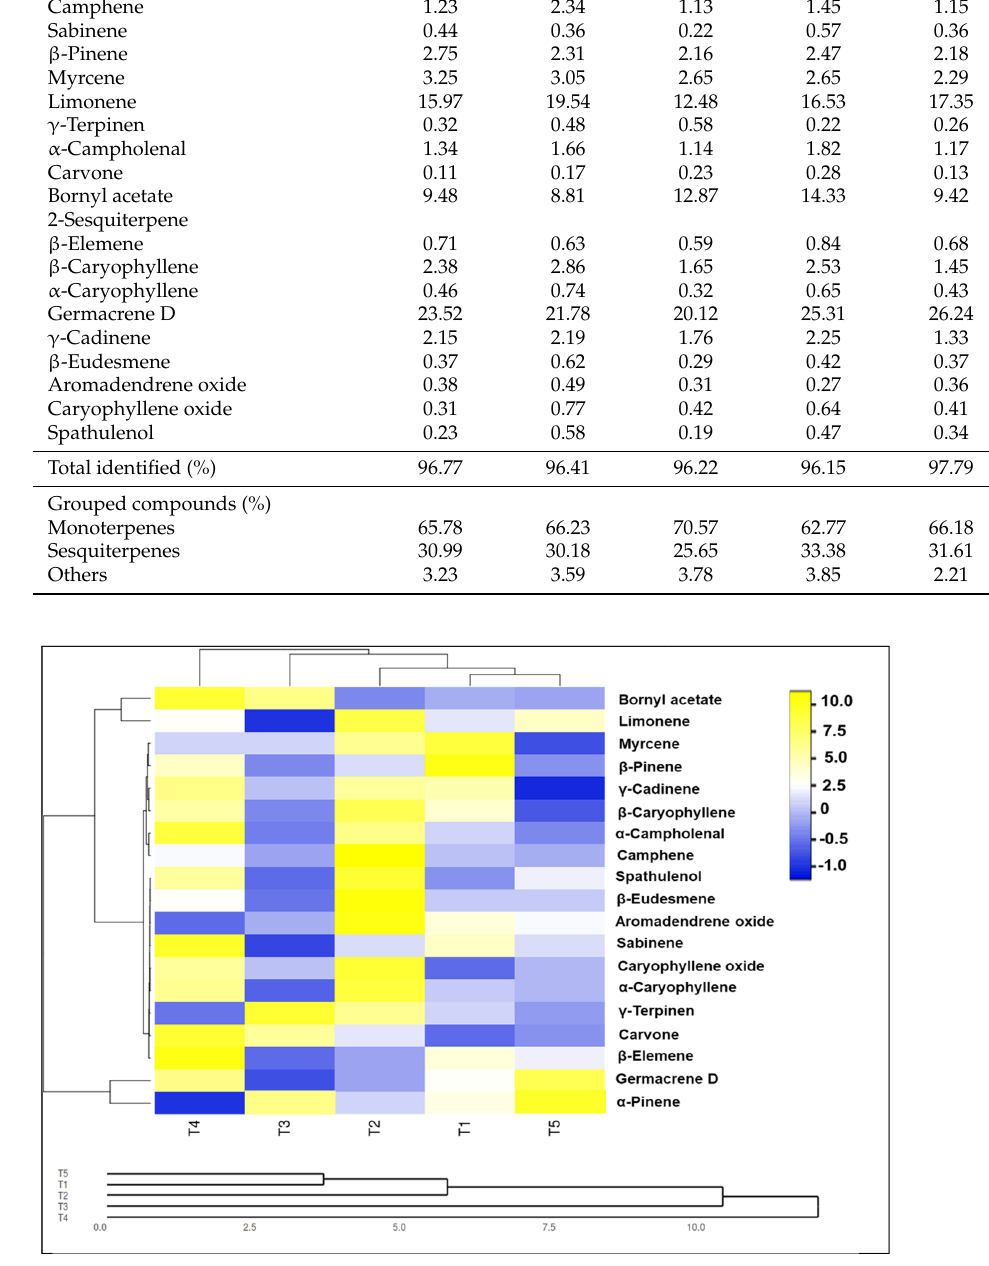
Figure 8. Heat map diagram clustering source treatments based on essential oil constituents in aer- ial parts of Solidago canadensis plants. The source treatments: T1 (control): chemical − NPK, T2: n − Si, T3: n − NPK, T4: nZE − loaded N, T5: n − Si + n − ZE-loaded N, under drought conditions. Rows in the heatmap represent different volatile compounds, while columns represent different treatments of nano-fertilizers. The key color bar indicates standardized mean values (dark blue indicates rela- tively lower mean values as negative relationships; dark yellow indicates relatively higher mean values as positive relationships).